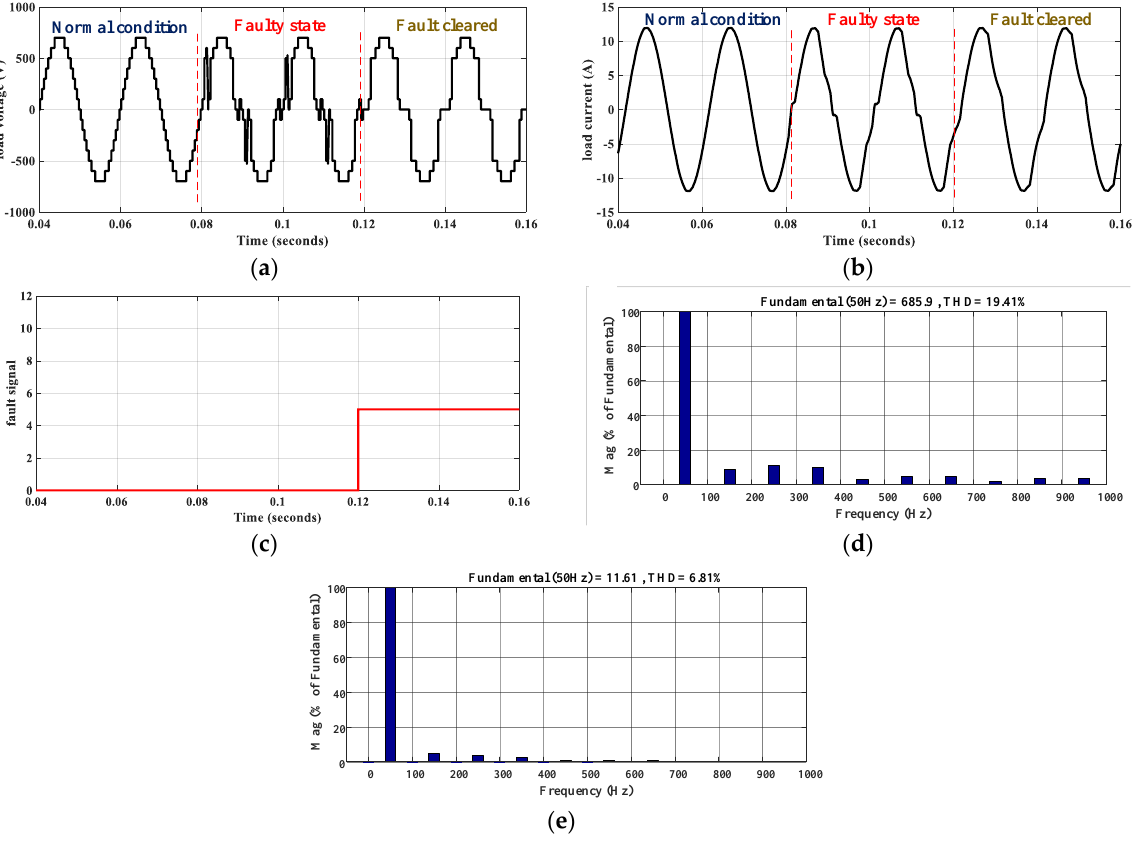
Figure 10. Simulation results for S 5 fault for ( a ) load voltage, ( b ) load current, ( c ) fault detection signal, ( d ) voltage harmonics profile, and ( e ) current harmonics profile.